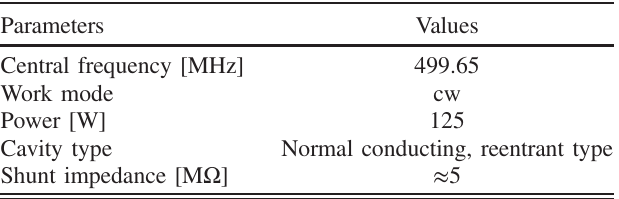
TABLE IV. The requirement of the parameters of the rf